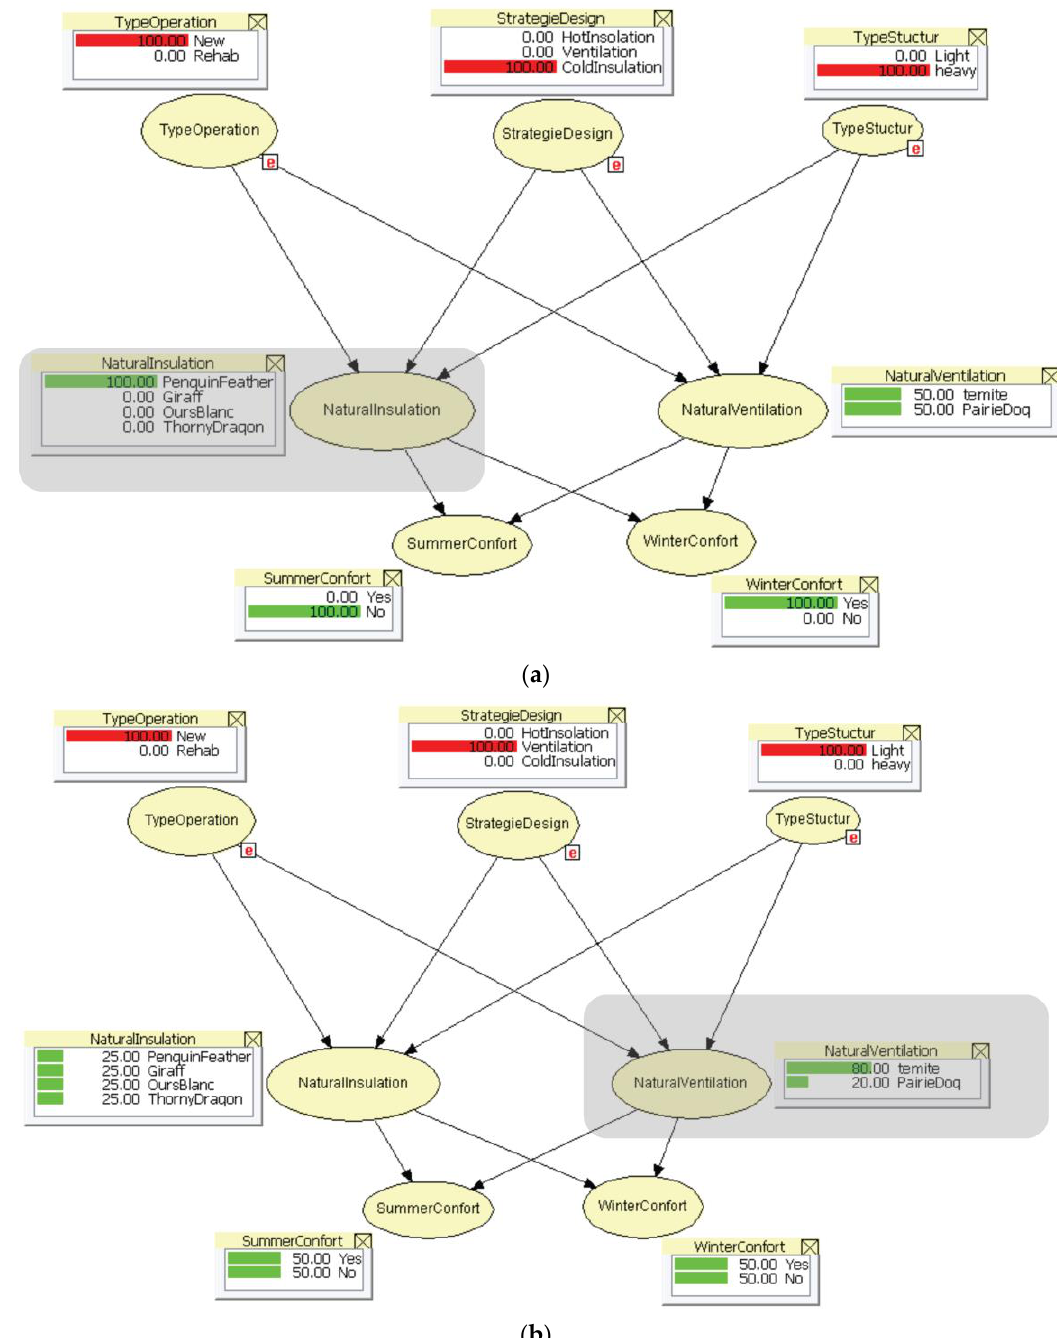
Figure 11. Decision-making aid tool: selecting nature strategy according to multi-criteria requirements ( a ) What nature strategy is the most appropriate for winter insulation with new construction and a heavy structure? (Penguin Feather 100%); ( b ) What nature strategy is the most relevant for natural ventilation in new construction and a lightweight structure? (Termite mound